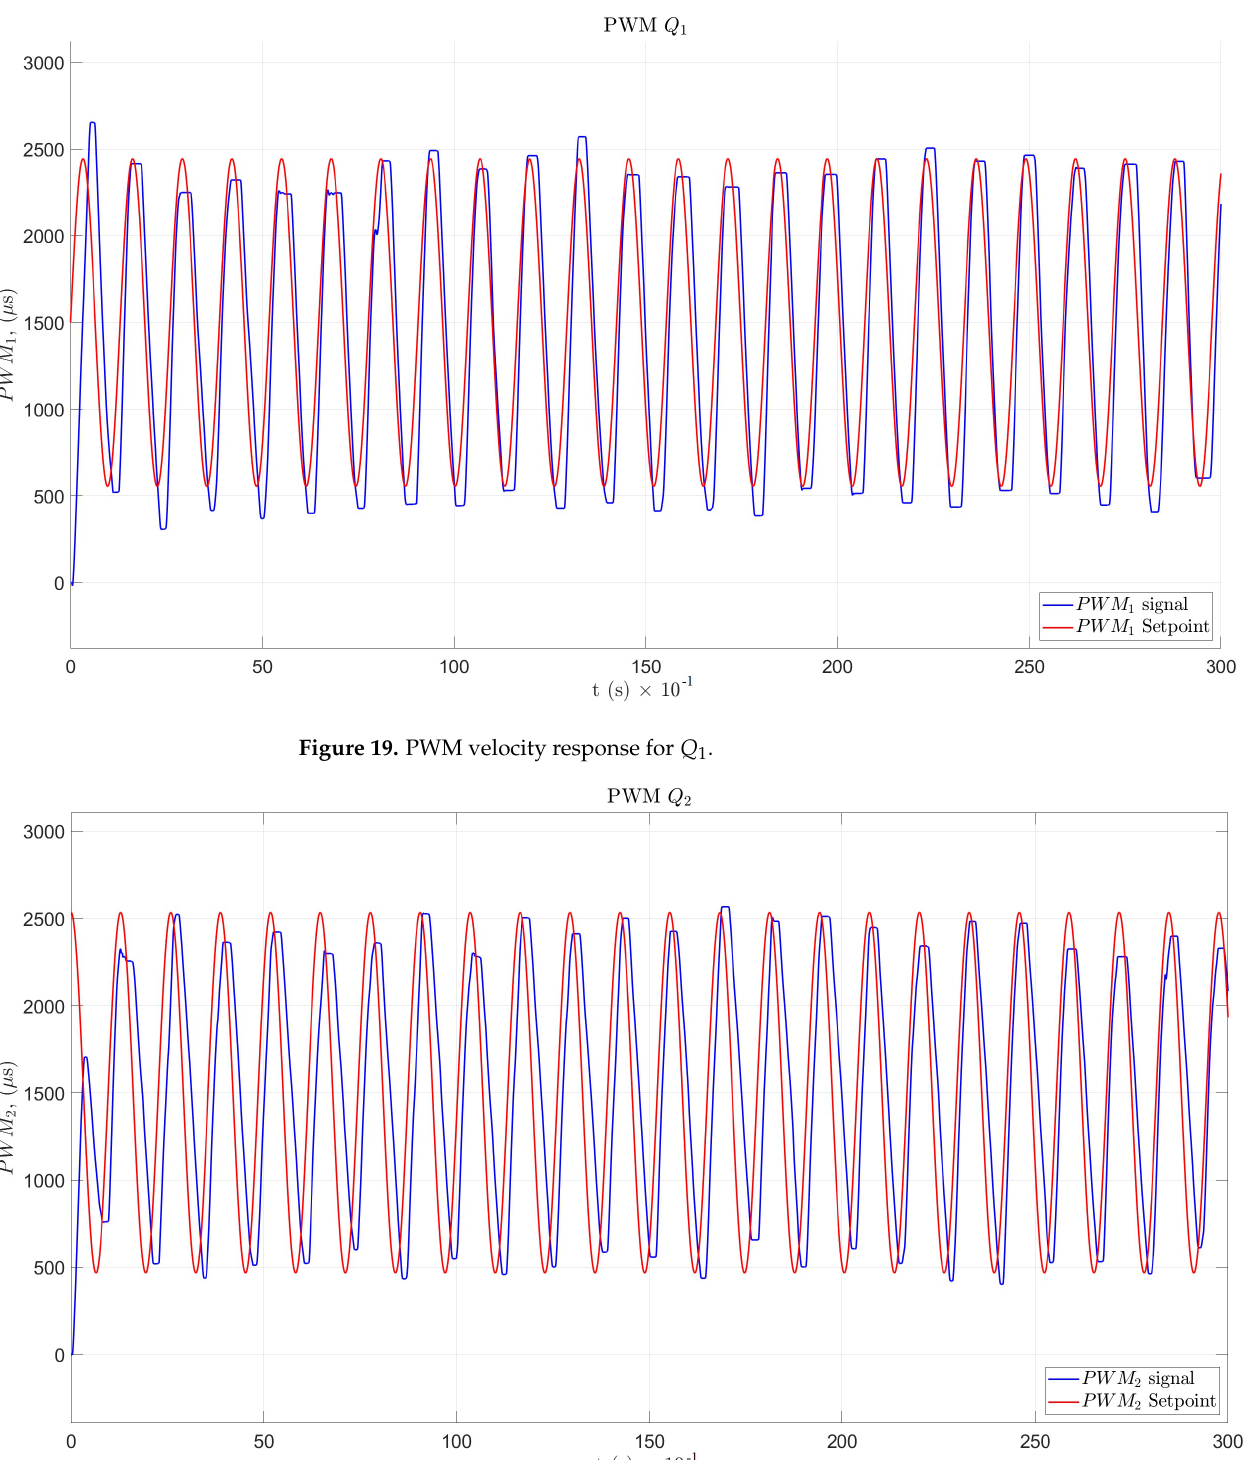
Figure 20. PWM velocity response for Q 2